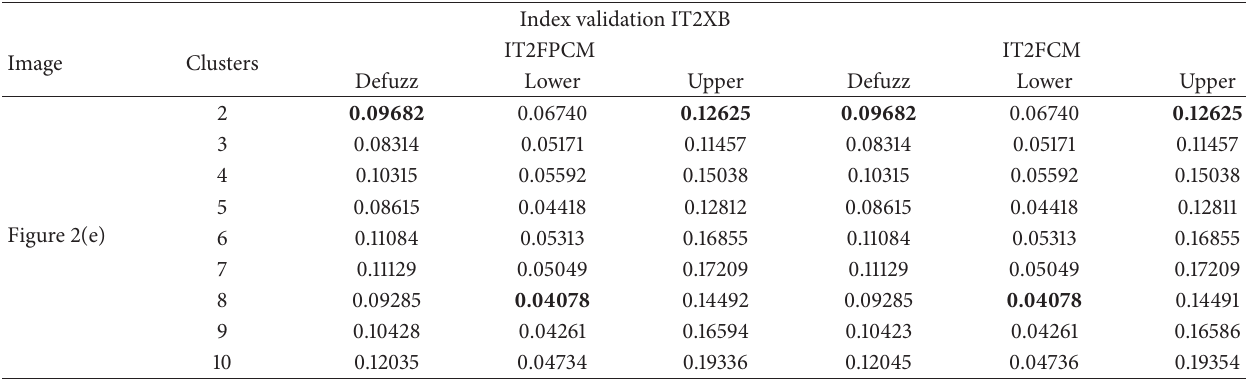
Table 43: Results of the IT2XB validation index to the clustering of image shown in Figure 2(e) using IT2FPCM and IT2FCM algorithm with 𝑚 = [1.5, 2.5] and 𝜂 = [1.5, 2.5] as parameters.